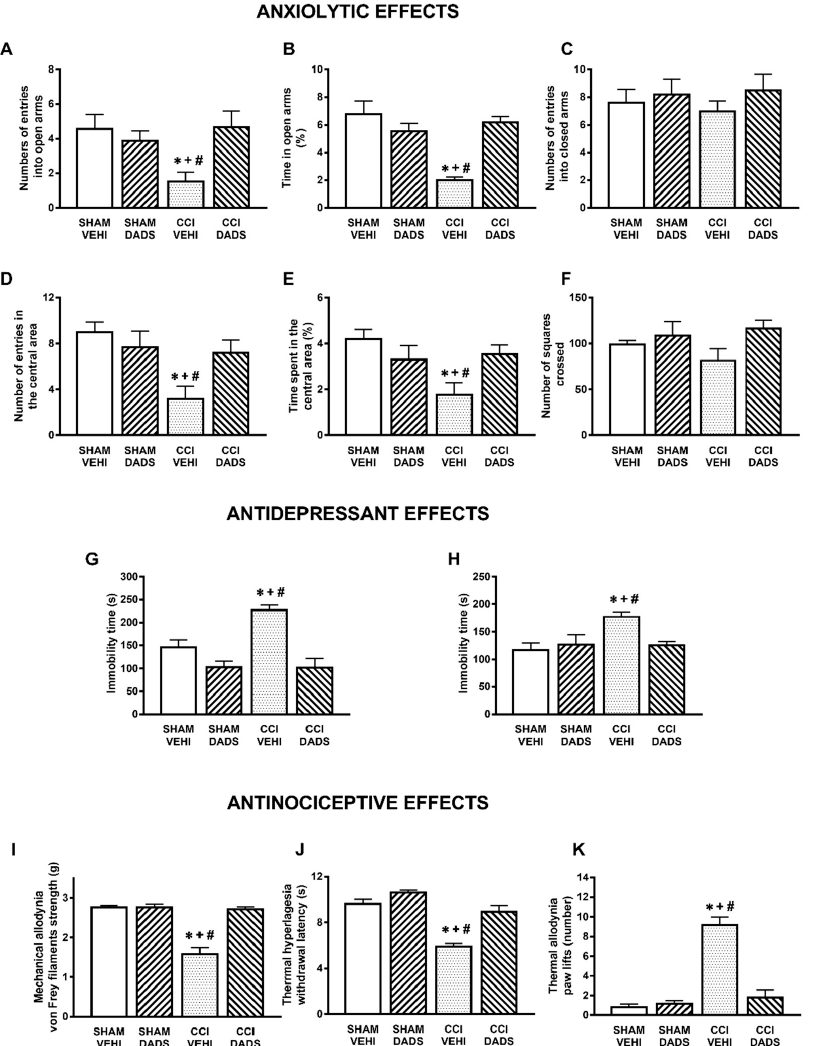
Figure 1. Treatment with DADS inhibited the anxiety- and depressive-like behaviors and the nociceptive responses induced by nerve injury. Effects of the repeated administration with DADS or vehicle at 150 μ mol/kg for 3 days, 2 times for each day, on the anxiety-, depressive-, and nociceptive-like behaviors induced by nerve injury at 30 days after surgery. The effects of DADS or vehicle in sham-operated mice are also displayed. In the EPM test, the number of entries to the open arms ( A ), percentage of the time spent in the open arms ( B ), and the number of entries into the closed arms ( C ) are shown. In the OF test, the number of entries in the central area ( D ), the percentage of time spent in the central area ( E ), and the number of squares crossed ( F ) are presented. In the TST ( G ) and FST ( H ), the immobility times (s) are shown. The effects of DADS in the mechanical allodynia ( I ), thermal hyperalgesia ( J ), and thermal allodynia ( K ) in the ipsilateral paw of sham-operated or sciatic nerve-injured mice are also indicated. For each test: * denotes significant differences vs. sham-operated mice treated with vehicle, + vs. sham-operated mice treated with DADS, and # vs. CCI mice treated with DADS ( p < 0.05; one-way ANOVA followed by the Student–Newman–Keuls test). Mean values ± SEM; n = 6–8 animals.